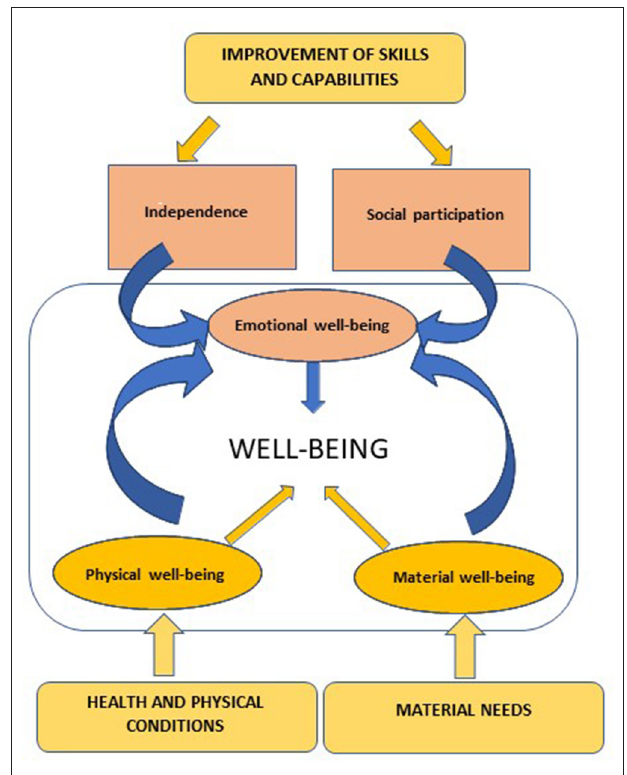
FIGURE 1 | Emotional value and quality of